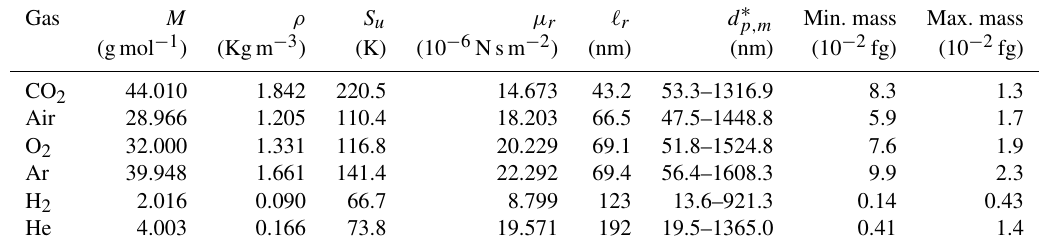
Table 1. Properties of gases at normal temperature and pressure (Kulkarni et al., 2011) and corresponding APM detection limits at λ = 0 . 5.